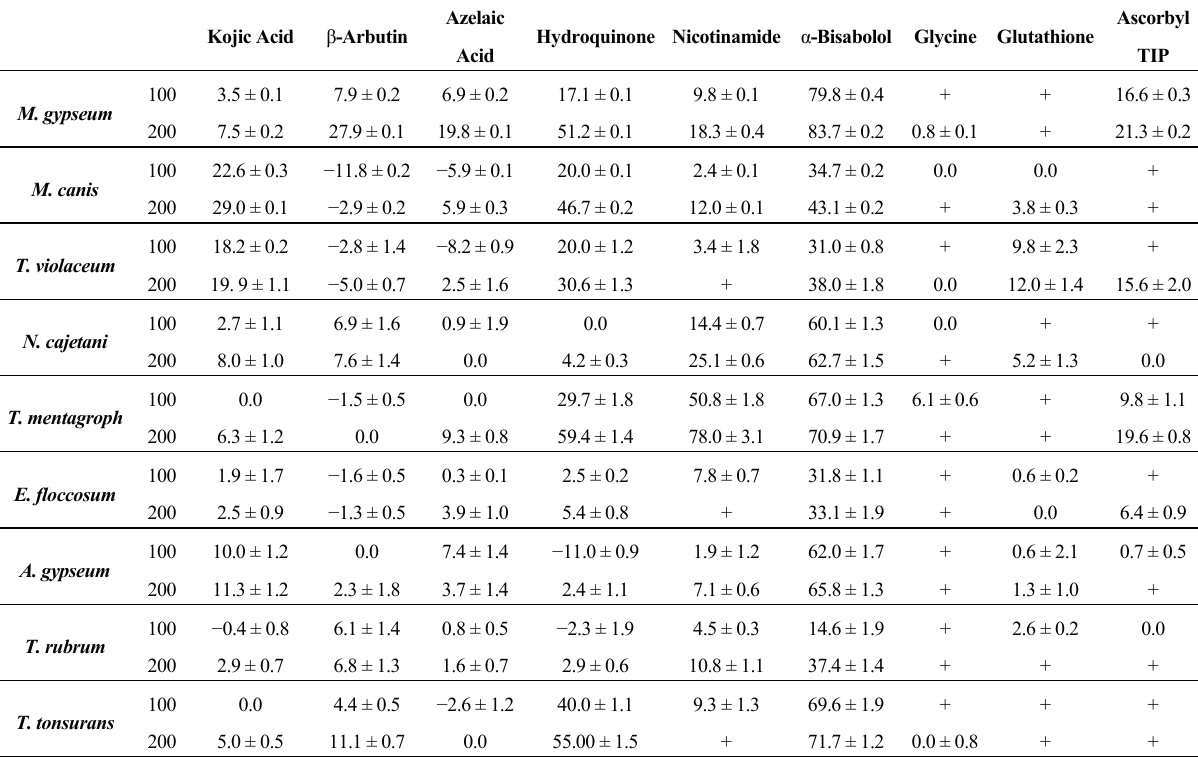
Table 1. Percent growth inhibition of dermatophytes treated with nine skin lighteners at 100 or 200 μ g/mL. Each value is the mean of three